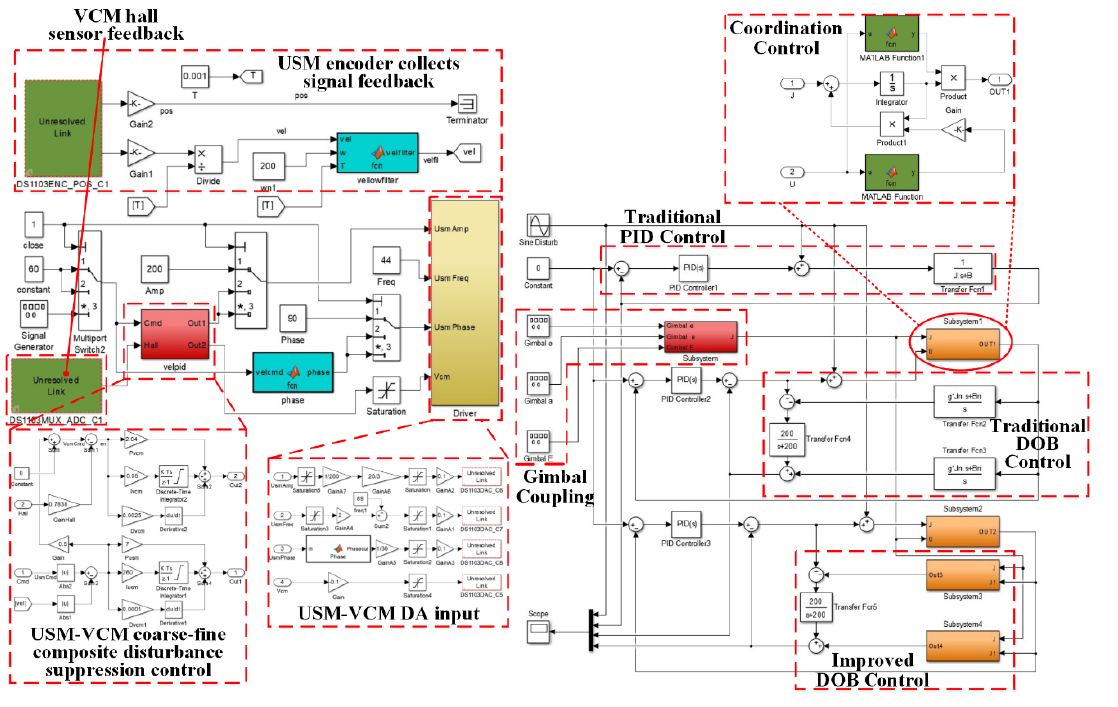
Figure 17. The simulation block diagram of the coarse–fine composite mechatronic controller. Table 1. Parameters and performance of the coarse–fine composite mechatronic system.